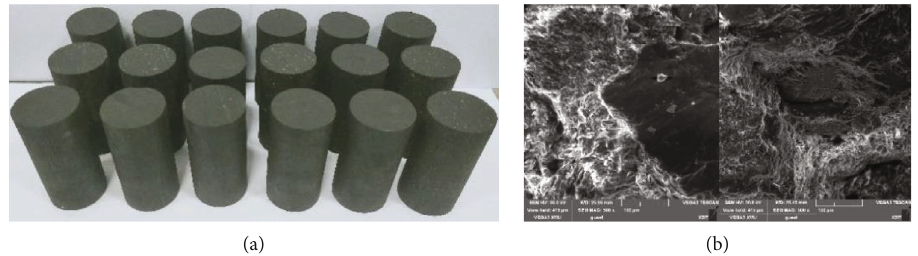
Figure 3: Standardized coal specimens and microstructure pro fi